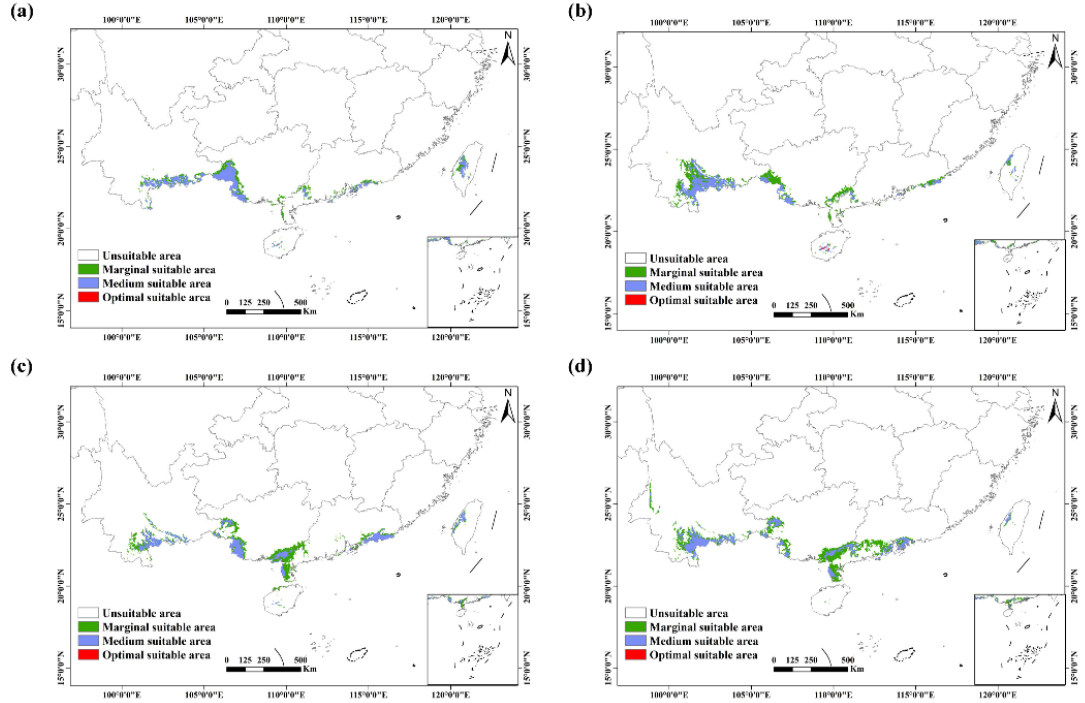
Figure 4. Projected potential distribution maps of H. tetratepala under future periods (2070s) in BCC-CSM2-MR models: ( a ) SSP 2.6, ( b ) SSP 4.5, ( c ) SSP 7.0, and ( d ) SSP